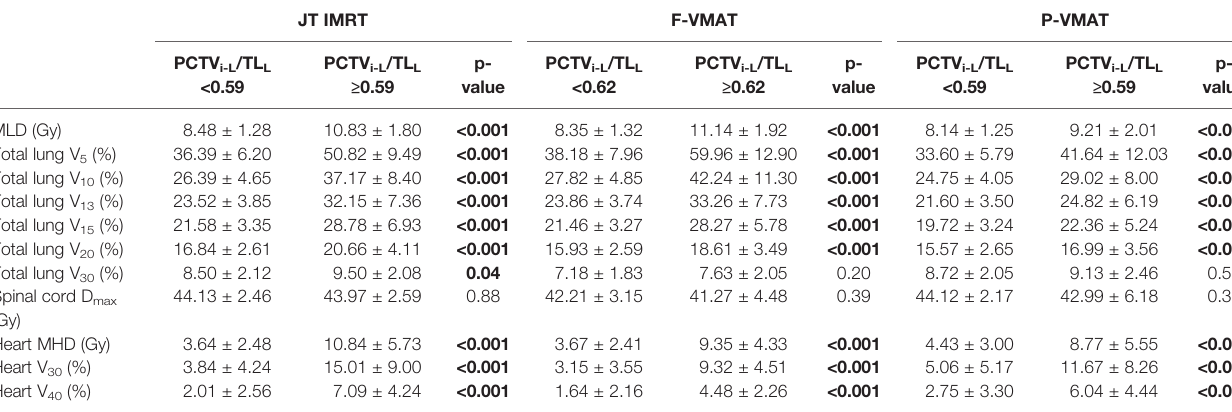
TABLE 6 | Dosimetric parameters with grouping PCTV inferior length/total lung length. JT IMRT F-VMAT P-VMAT PCTV i-L /TL L PCTV i-L /TL L PCTV i-L /TL L ≥ 0.59 <0.59